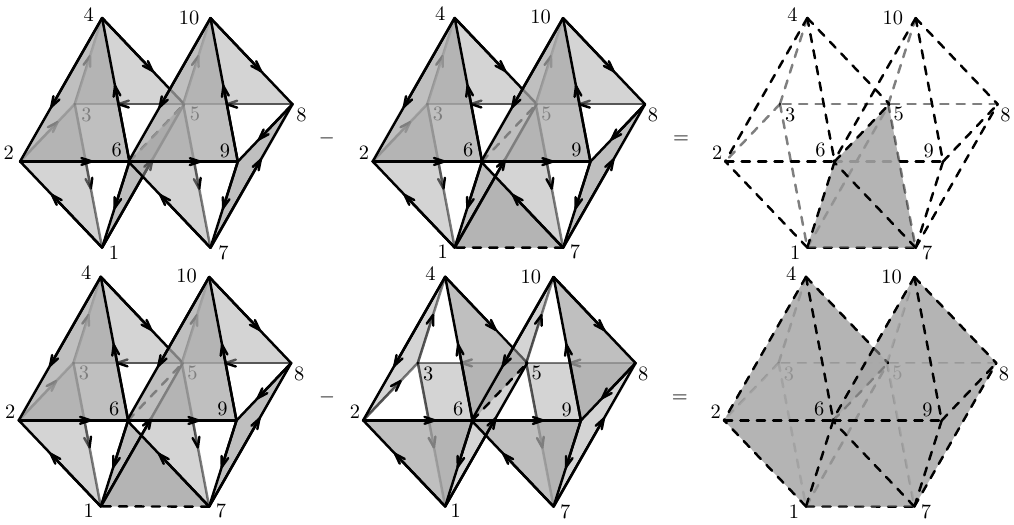
Figure 7 . A sequence of two sphere moves between the set of triangles from (3.21). Top: sphere (square) move on the labels f 1 ; 5 ; 7 ; 6 g from (3.26). Bottom: sphere move on all the la- bels from